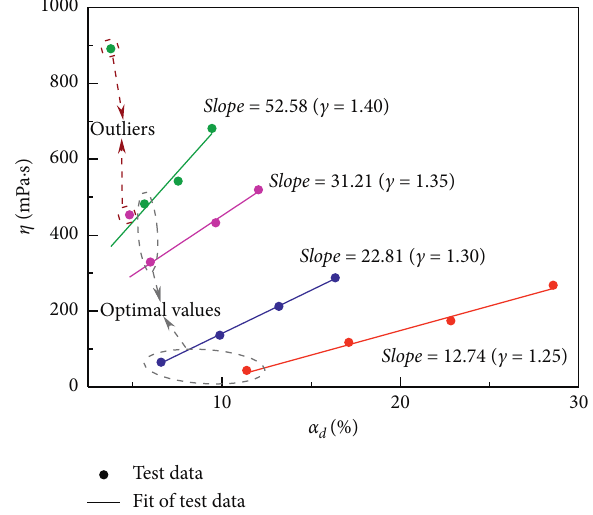
Figure 15: Regression of the viscosity with respect to the mass ratios of the